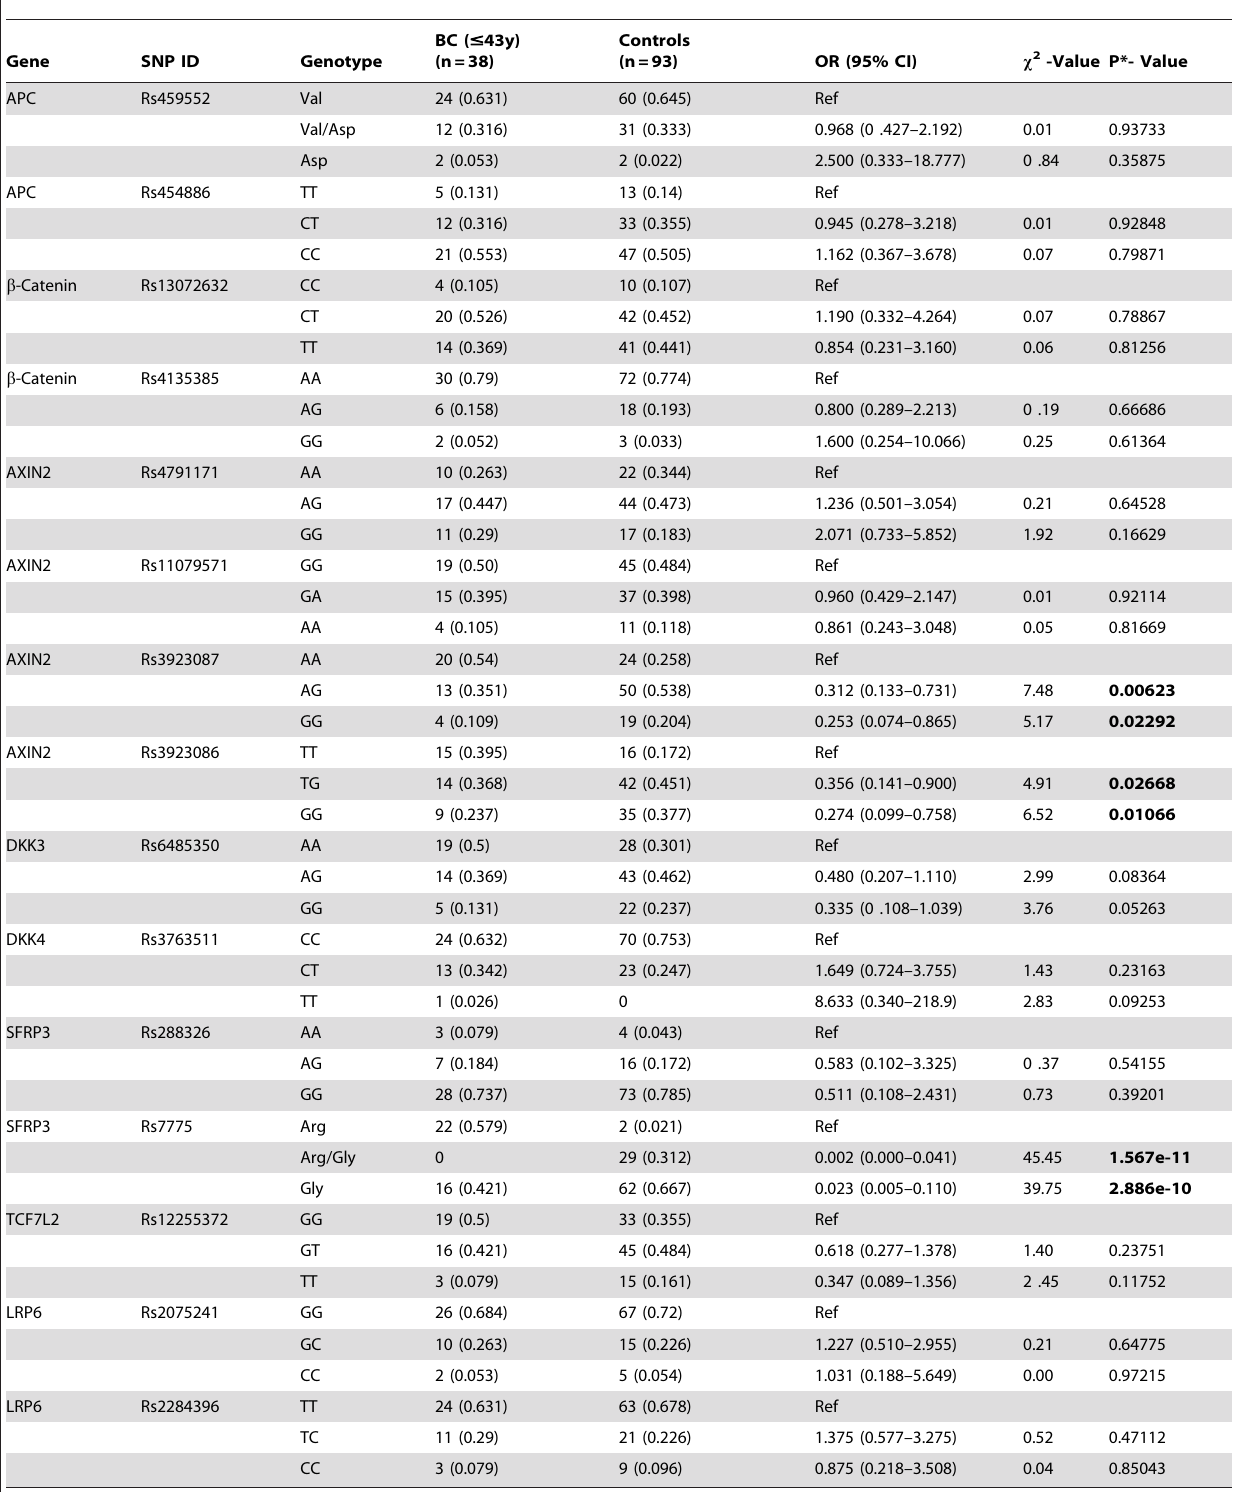
Table 3. Comparison of genotype frequencies of SNPs in Wnt pathway genes between early on-set Breast cancers (patients age # 43 years) versus